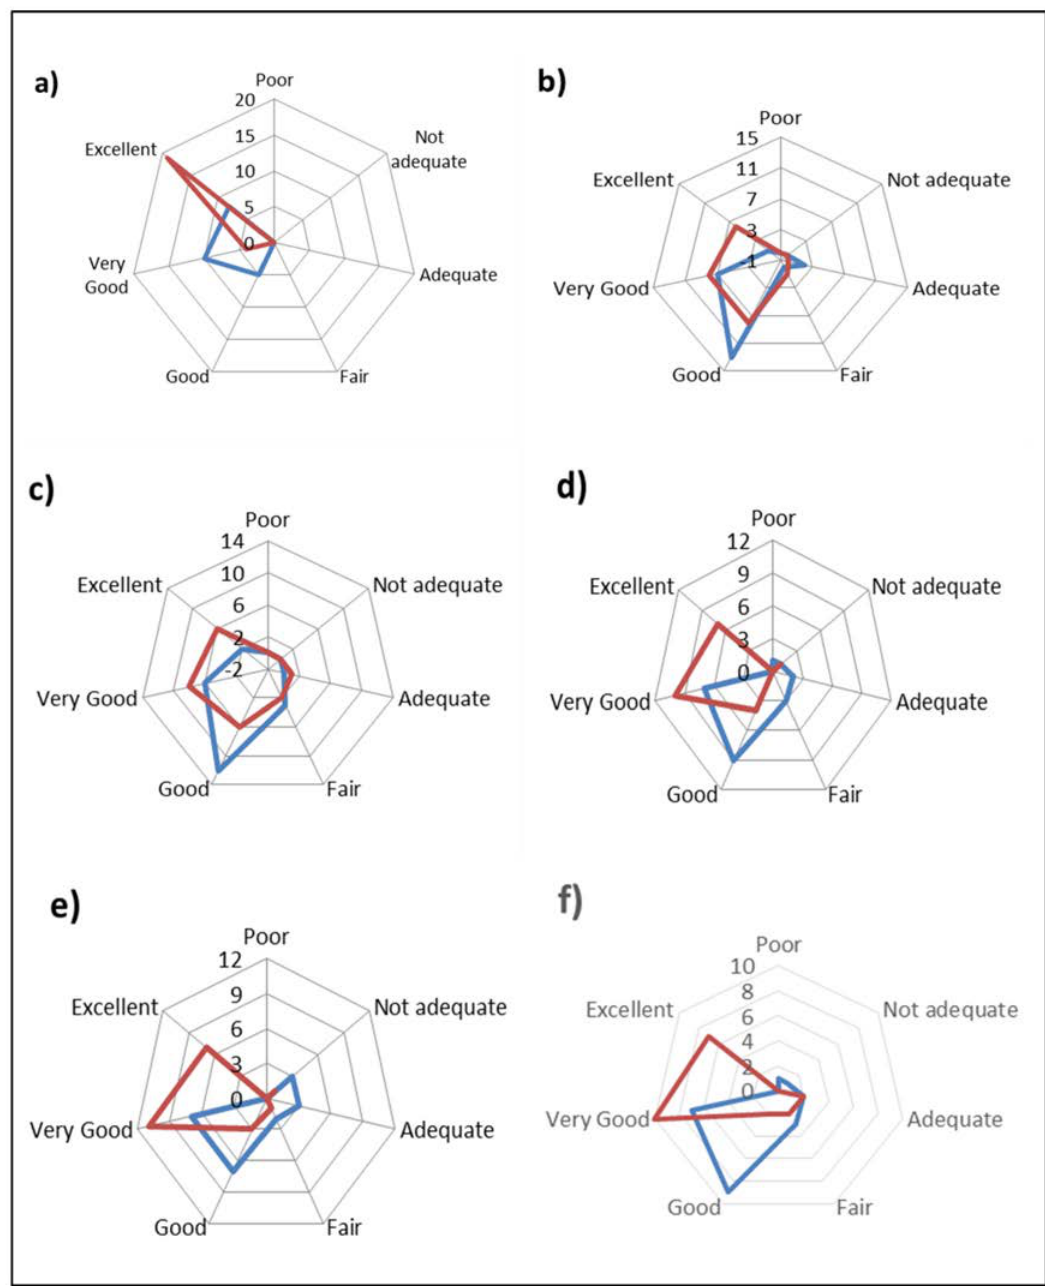
Figure 4. Consumer evaluation of cheeses from two groups CTR cheese (blue) and OC cheese (red) for: ( a ) appearance; ( b ) color; ( c ) texture; ( d ) smell; ( e ) taste; ( f ) overall acceptance. CTR group: five cheese wheels after 60 days of ripening obtained from the milk of dairy cows fed concentrate without olive cake supplements. OC group: five cheese wheels after 60 days of ripening obtained from the milk of dairy cows fed concentrate with olive cake